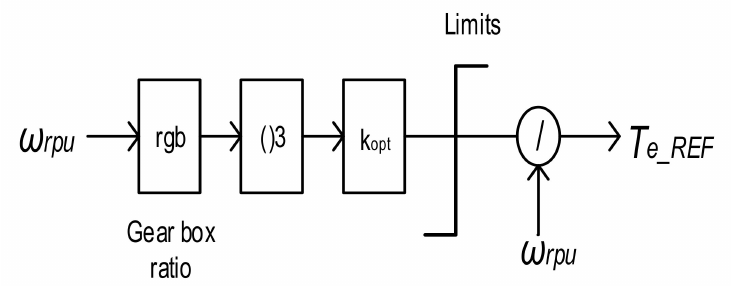
Figure 5. DFIG maximum power point tracking (MPPT)